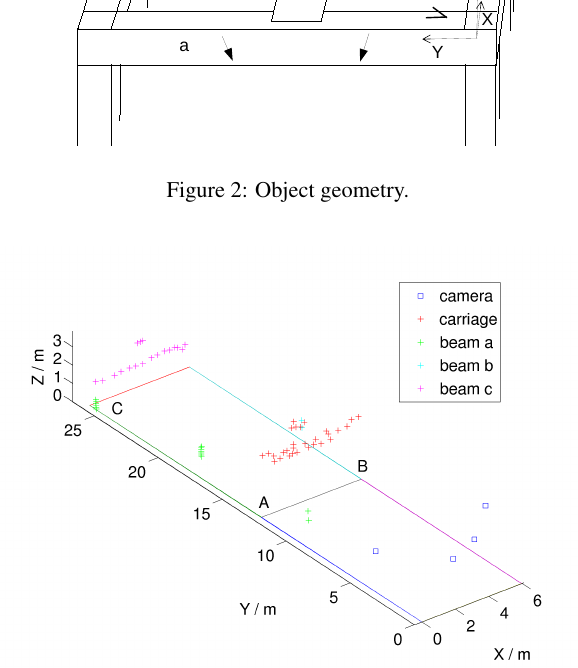
Figure 3: Measured target points and camera locations in the ob- ject coordinate system before